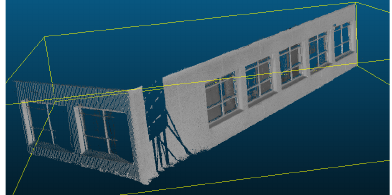
Figure 7: The point cloud obtained by our TLS